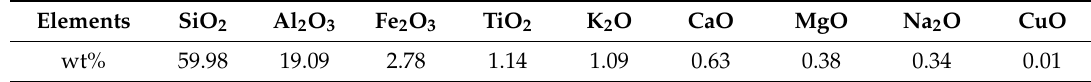
Table 2. Chemical composition of fly ash (FA) in wt%